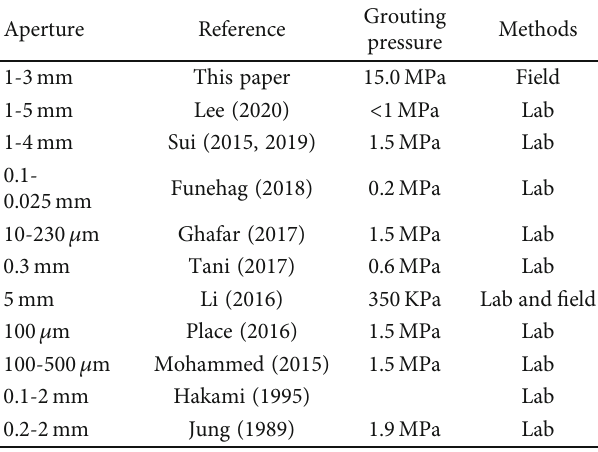
Table 2: Fracture apertures and its application